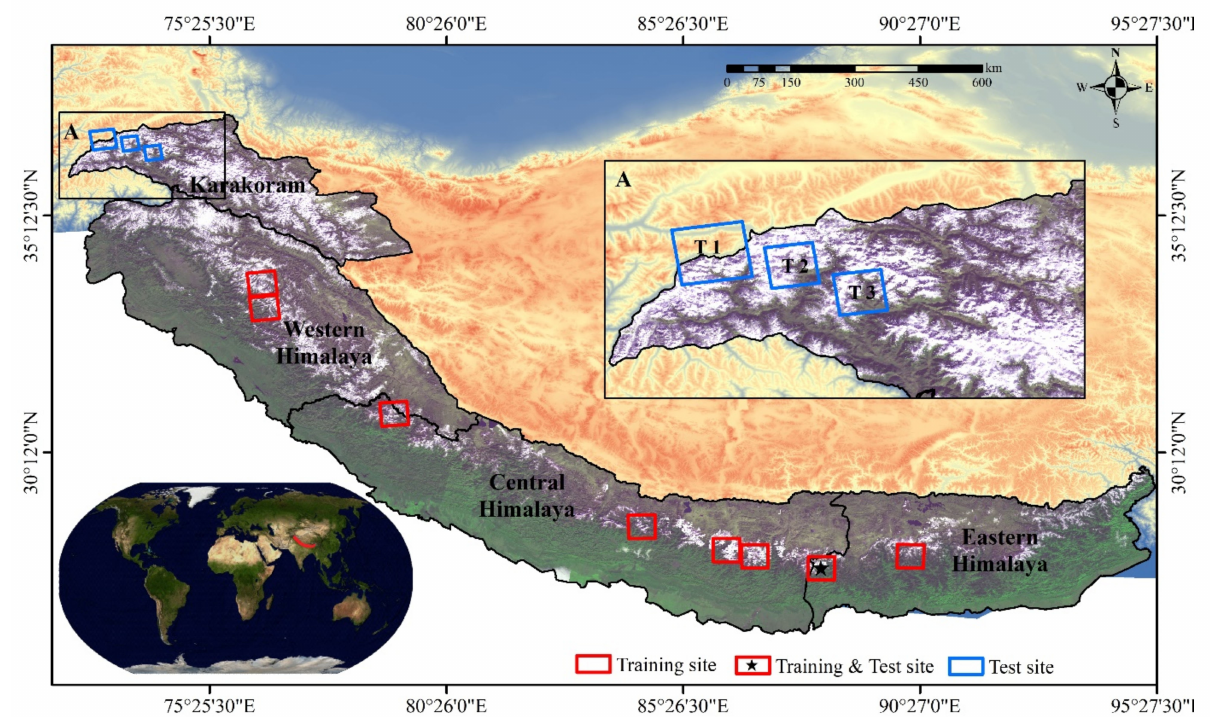
Figure 1. Spatial distribution of the test (blue) and training (red) sites across the Himalaya and Karakoram regions. The star denotes region, which was used as both training and testing data. The Himalayan and Karakoram boundaries were taken from Nie et al.